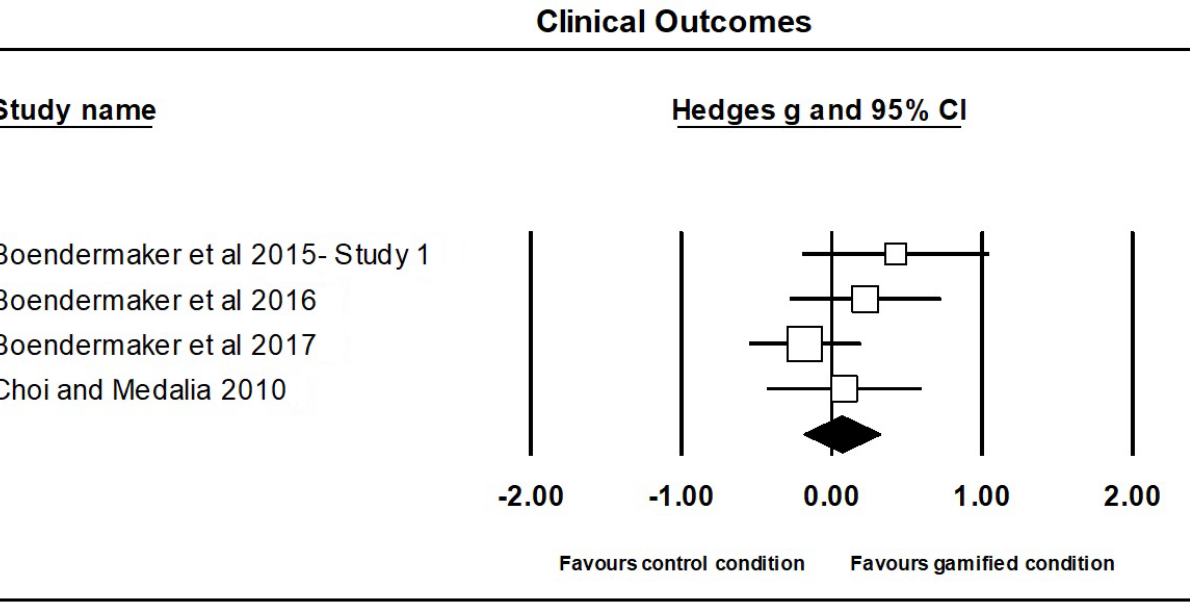
Figure 6. Forest plot of overall effect sizes comparing gamified condition and control condition (ie, non- or less-gamified version) on clinical outcomes for individual studies in alphabetical